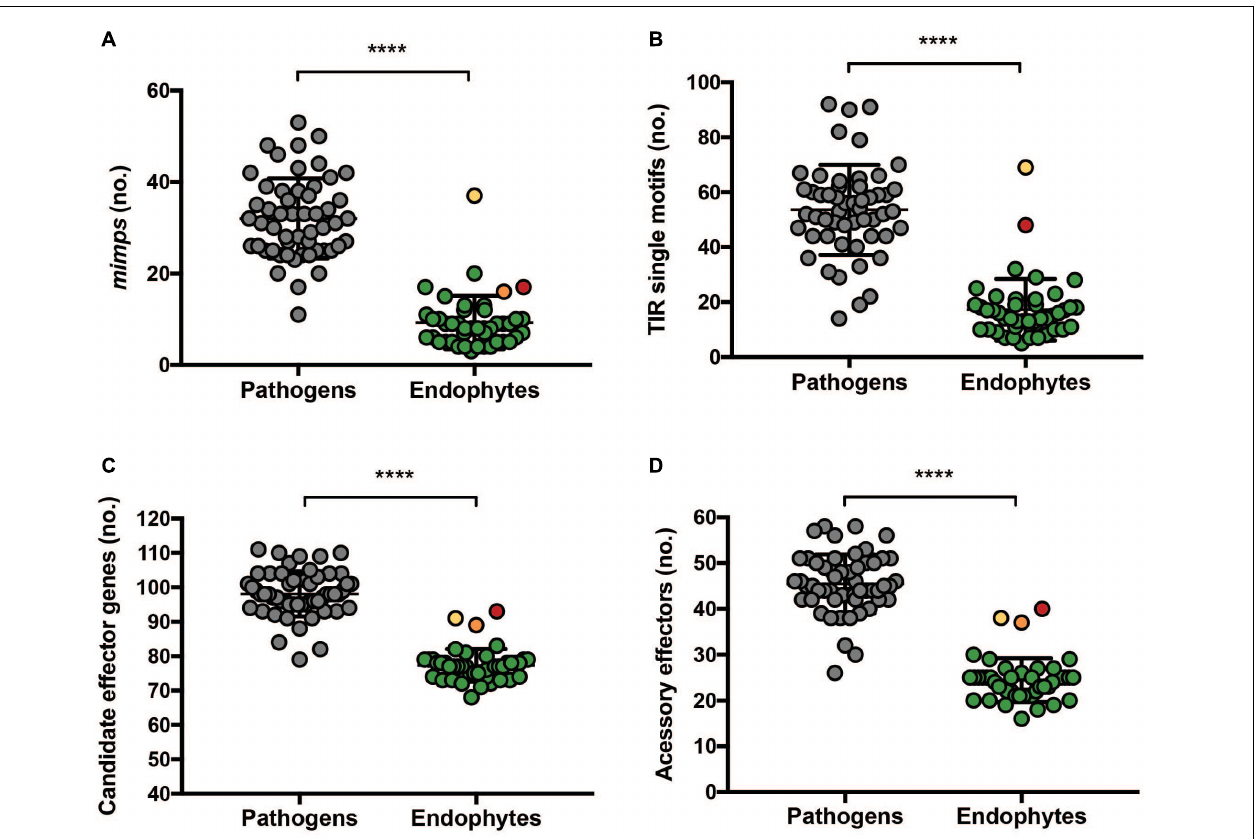
FIGURE 5 | Endophytic Fo have fewer mimps and fewer putative effectors than pathogenic Fo. (A) Complete and (B) incomplete terminal inverted repeats (TIR) were predicted from 45 endophytic genomes and 53 pathogenic isolates (ForlCL57, FOSC3A, and FoMN14 were omitted from the analysis for not being pathogenic nor tested for endophytism on tomato and Fol4287, Forc016, and Fo47 were omitted because they were sequenced by Pacbio). Data were analyzed by a non-parametric Mann–Whitney U test (**** P < 0.0001). Endophytic isolates (45 strains) and 55 pathogenic strains were used for predicting (C) candidate effectors and (D) candidate effectors located on the accessory genome. Accessory effectors were defined as candidate effectors which do not have a homolog on the core genome of Fo47. The colors correspond to Fo14 (red), Fo10 (orange), and Fo3 (yellow). Data were analyzed by a non-parametric Mann–Whitney U test (**** P <